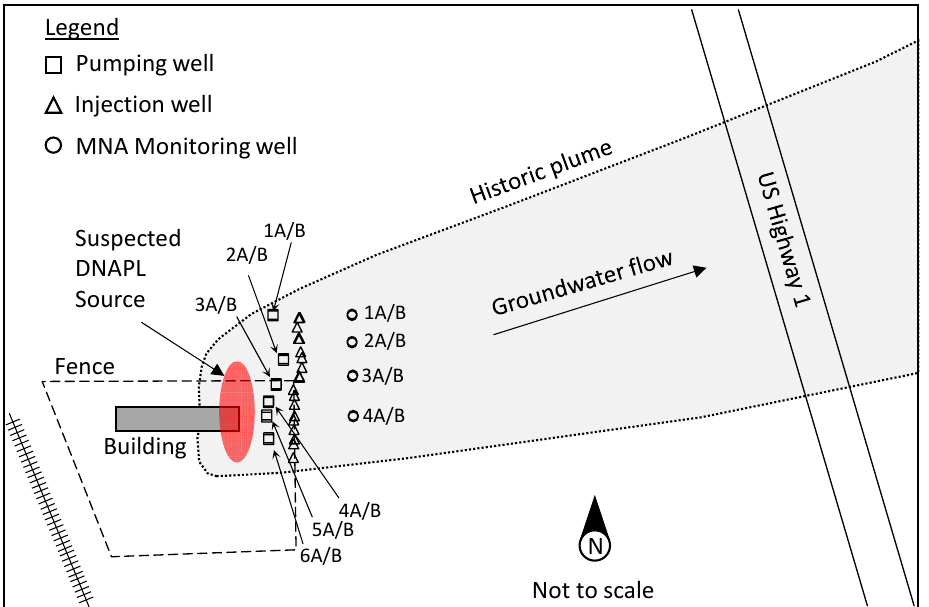
Figure 1. Conceptual PFC site map at Cocoa, Florida, showing source area in red, and contaminant plume in gray. (Adapted from Parker et al. [18] and Geosyntec [62].)